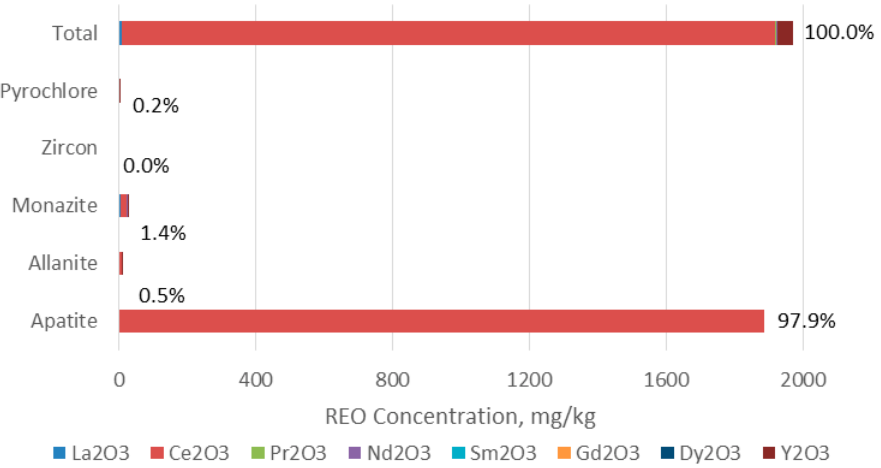
Figure 3. REO concentrations in the REE-bearing phases of the concentrate (mg/kg).